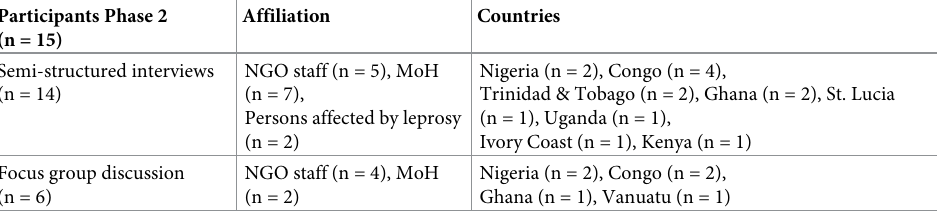
Table 3. Participants–Phase